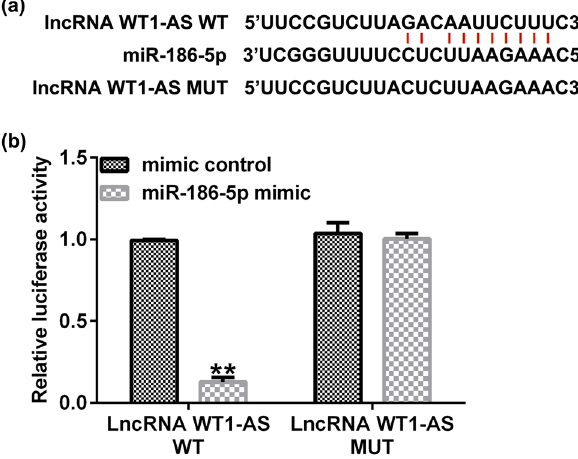
Figure 3: miR - 186 - 5p directly targets lncRNA WT1 - AS. ( a ) A sche - matic of miR - 186a - 5p binding site in lncRNA WT1 - AS 3 ′ - UTR. ( b ) The interaction between miR - 186a - 5p and lncRNA WT1 - AS was con fi rmed via dual - luciferase reporter assay. ** P < 0.01 vs mimic control. miR, microRNA; lncRNA, long noncoding RNA; WT1 - AS, WT1 antisense RNA; WT, wild - type; MUT, mutant; UTR, untranslated